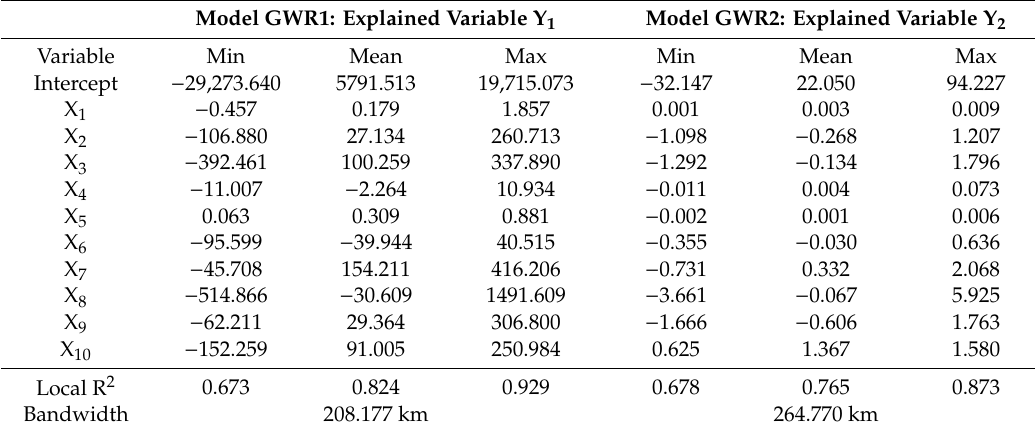
Table 4. General characteristics of Geographically Weighted Regression (GWR) model parameters with response variables Y 1 and Y 2 .